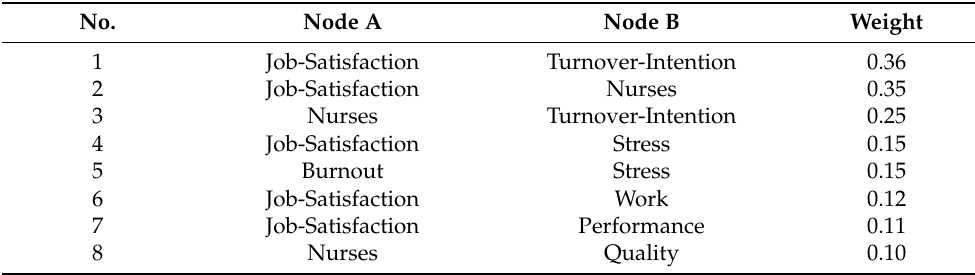
Table 1. Thematic network job-satisfaction 1992–2010. Relationships with a weight equal to or greater than